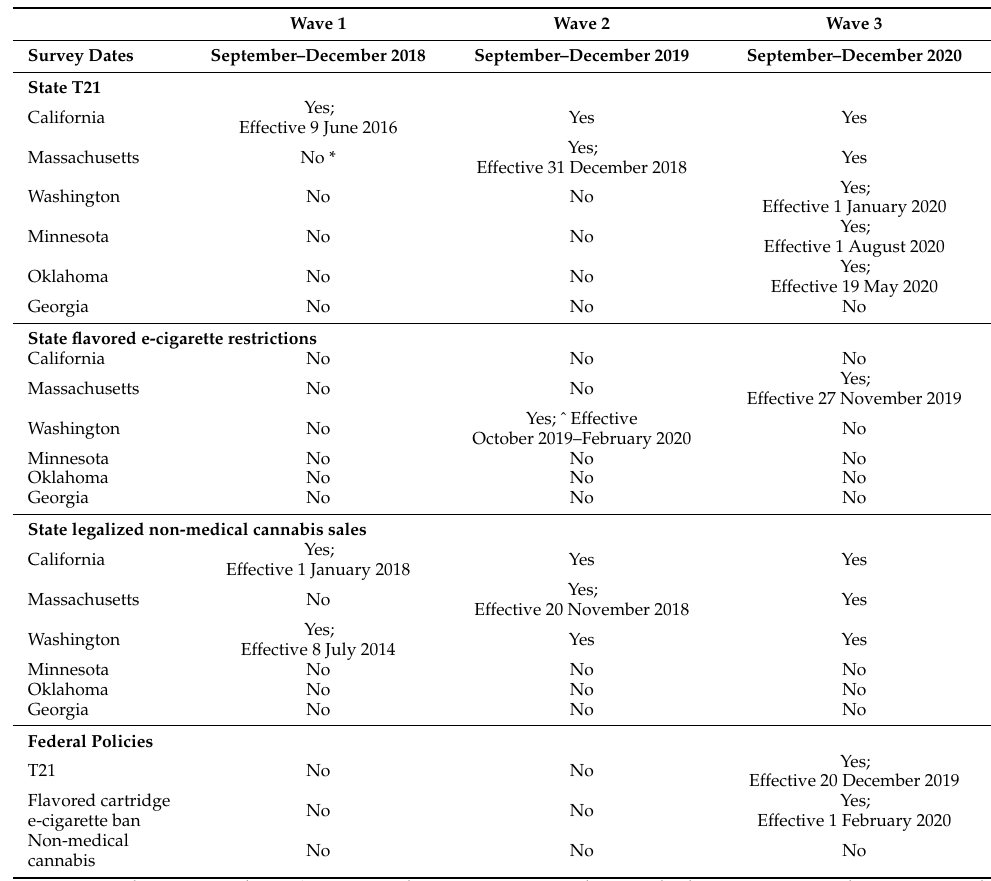
Table 1. Timeline of state and federal e-cigarette related policies (i.e., T21, restrictions on flavored e- cigarettes, and legalized non-medical cannabis sales) in effect in fall 2018 (Wave 1), fall 2019 (Wave 2), and fall 2020 (Wave